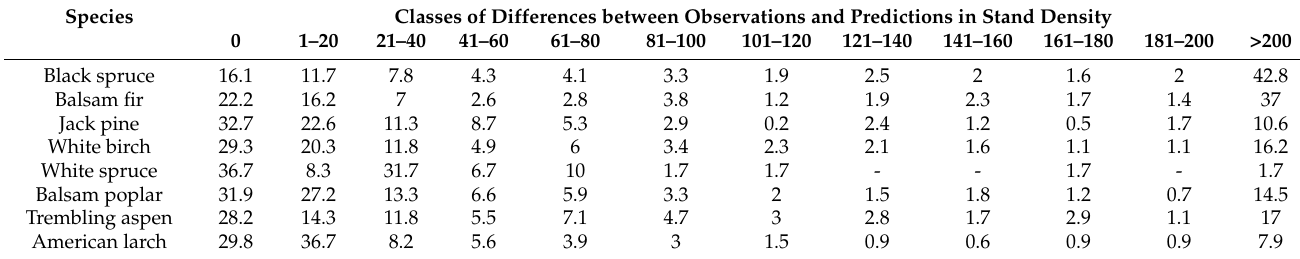
Table 8. Percentages of plots in different classes (20 trees ha − 1 ) of differences between observed and predicted stand densities (trees ha − 1 ) in Ecoregion 3E, northern Ontario, Canada. Species Black spruce